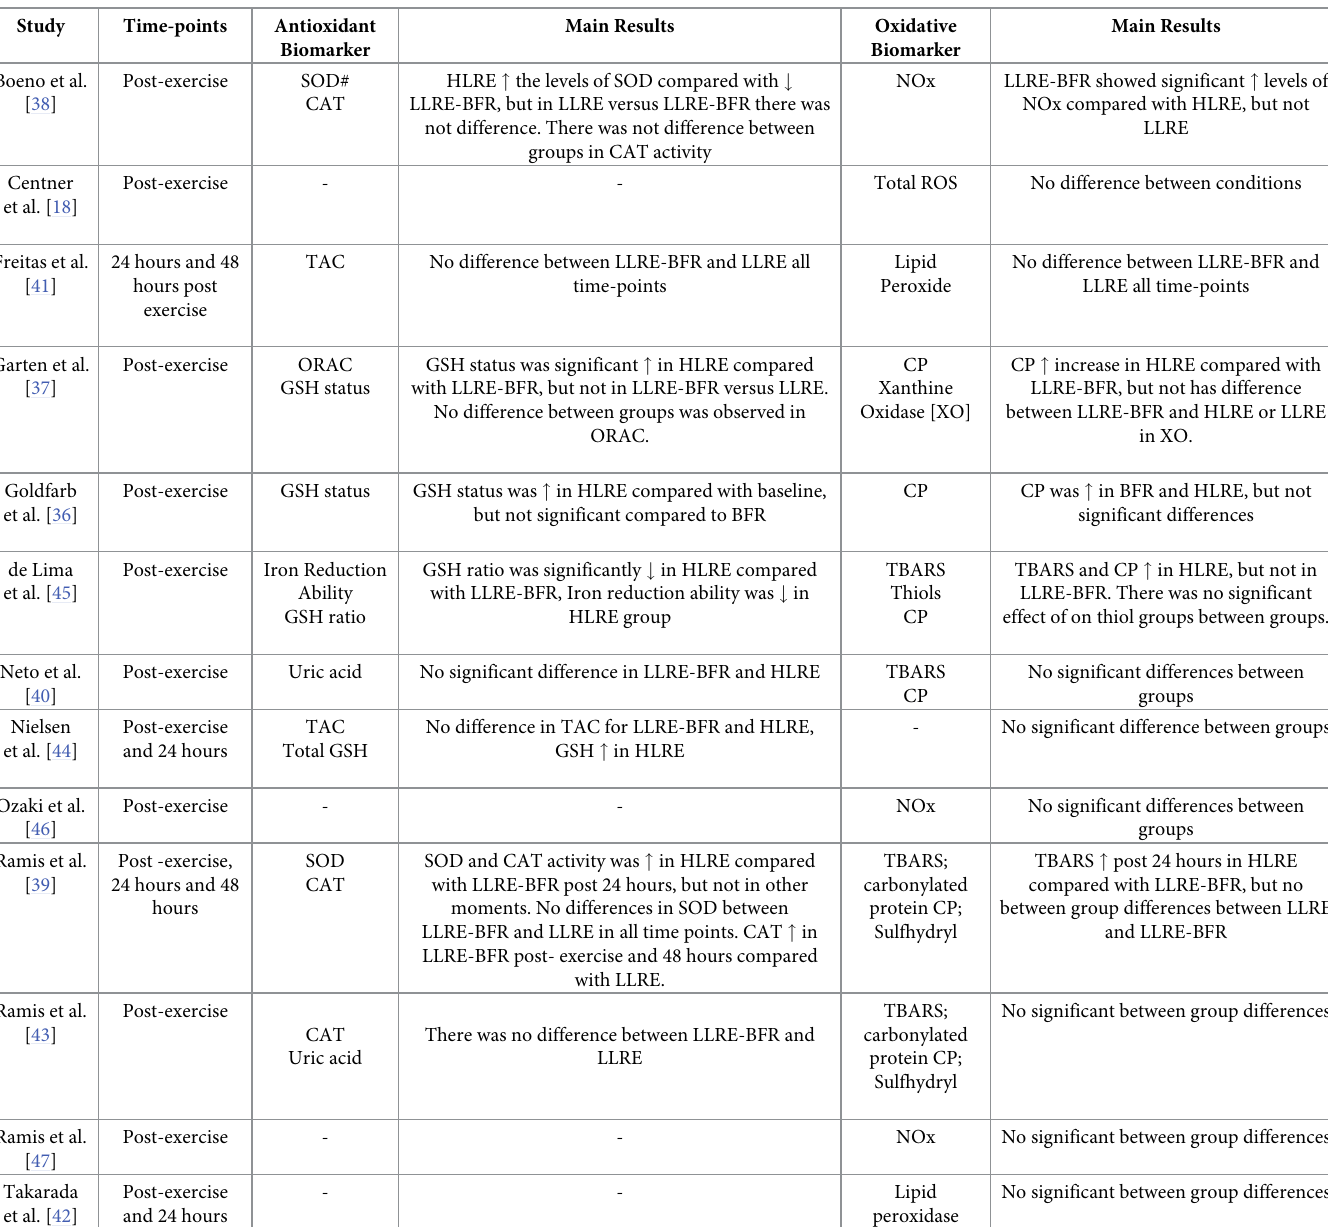
Table 3. Description of study results in LLRE-BFR versus HLRE and LLRE on antioxidant and oxidative biomarkers based on changes